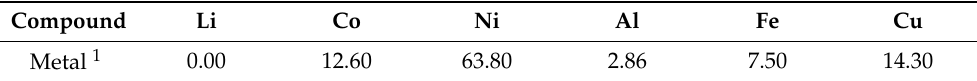
Table 8. ICP-OES analysis of relevant elements in the produced metal fraction after the InduMelt experiment in wt.-%.